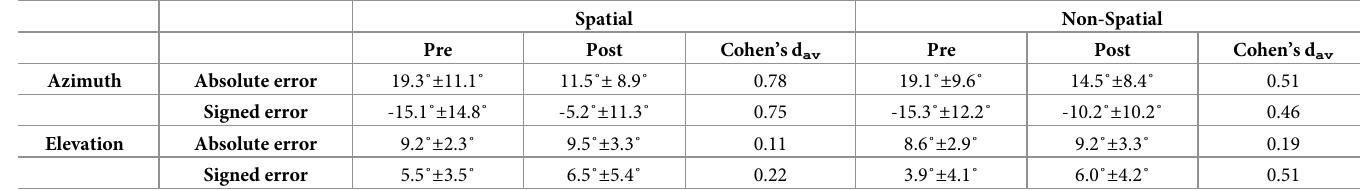
Table 1. Mean ± SD and Cohen’s d av for absolute and signed errors in azimuth and elevation as a function of PHASE (pre or post training) and training (Spatial or Non-Spatial during monaural listening). Results are pooled irrespective of the order in which the two training tasks were